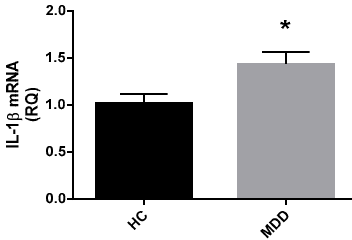
Figure 7. Whole blood mRNA expression of) IL-1 β in depressed patients and healthy controls.Relative quantification of mRNA expression for IL-1 β in depressed patients (a: n = 42) compared with healthy controls ( n = 21). Data expressed as mean with SEM. Statistical analysis was conducted with a Mann Whitney-U test on log transformed RQ data. * p < 0.05 vs. controls.